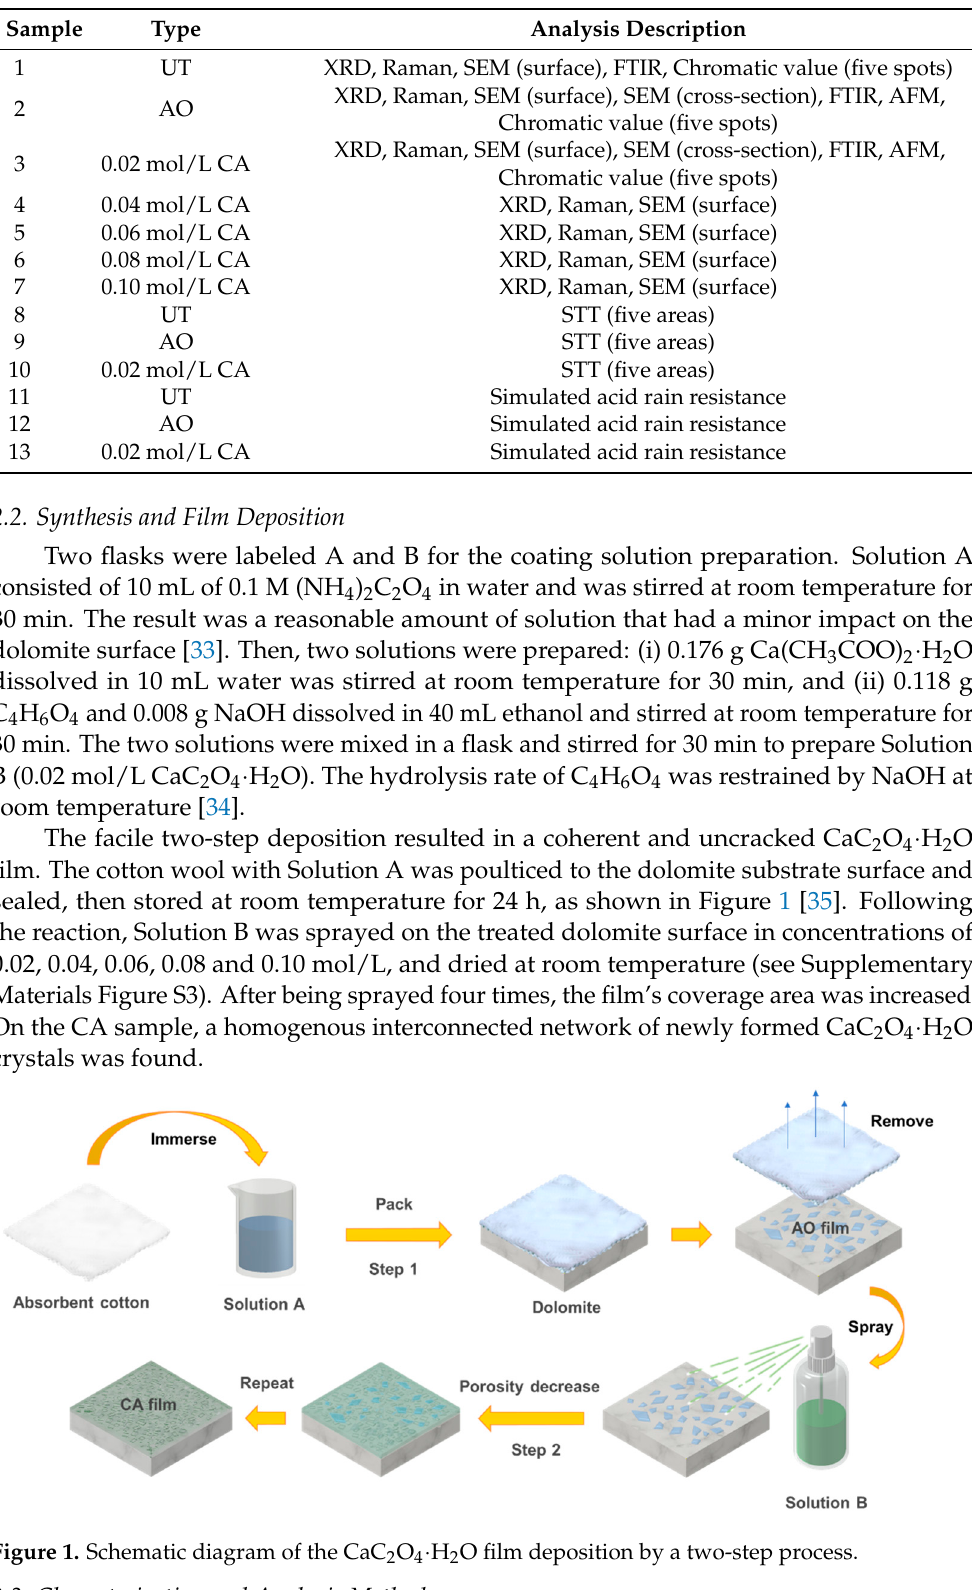
Table 1. Characteristics of the samples.